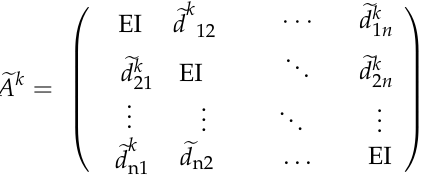
Figure 2. SF-AHP-WSM flow chart.